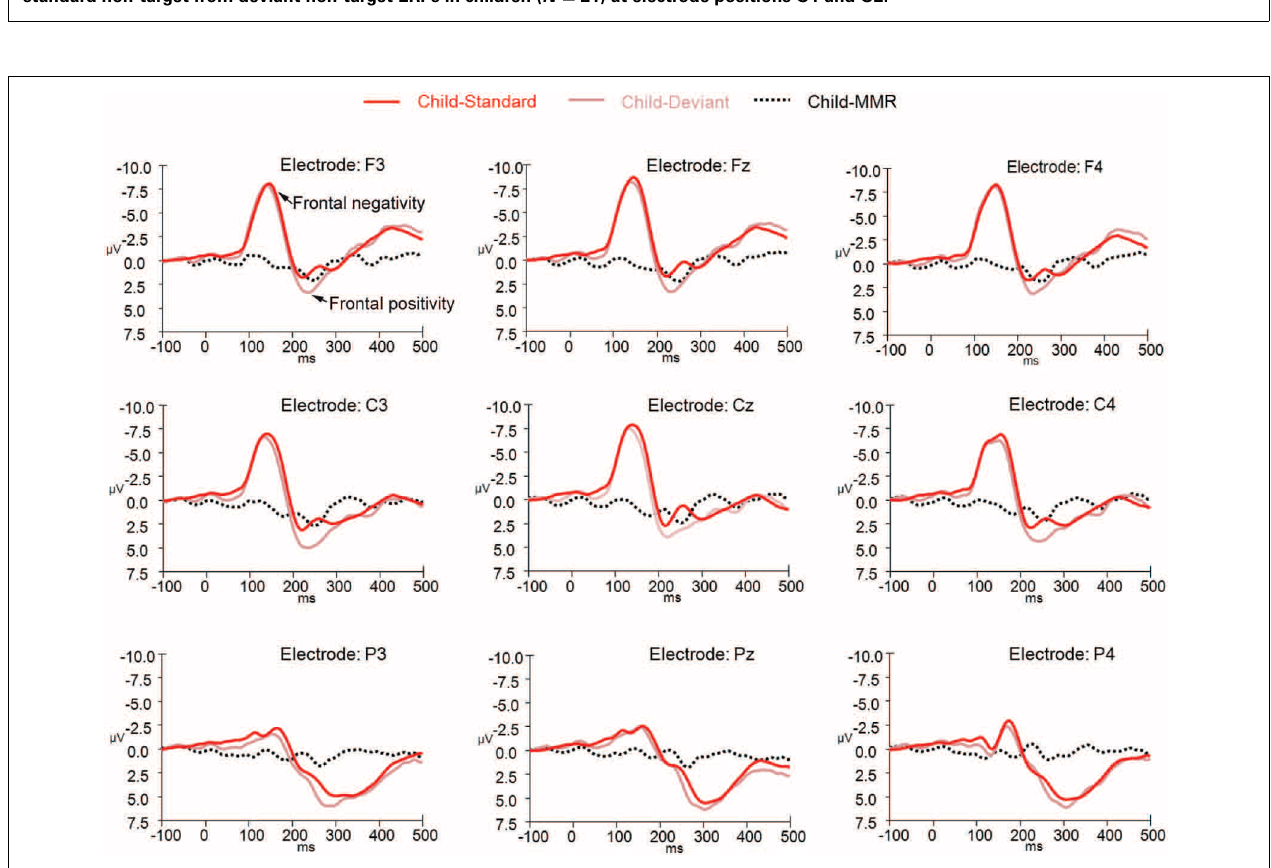
FIGURE 5 | ERPs for deviant non-target and standard non-target stimulus conditions as well as the difference wave computed by subtracting standard non-target from deviant non-target ERPs in children ( N = 21) at electrode positions F3, Fz, F4, C3, Cz, C4, P3, Pz, and P4.